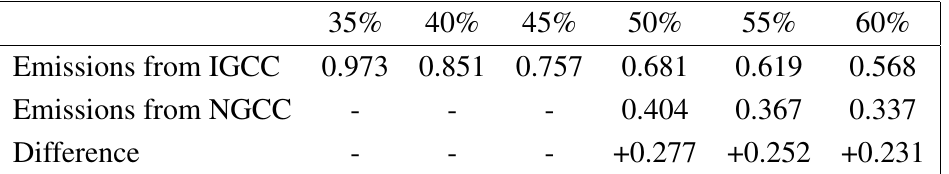
/MW h ) as a function of efficiency 2